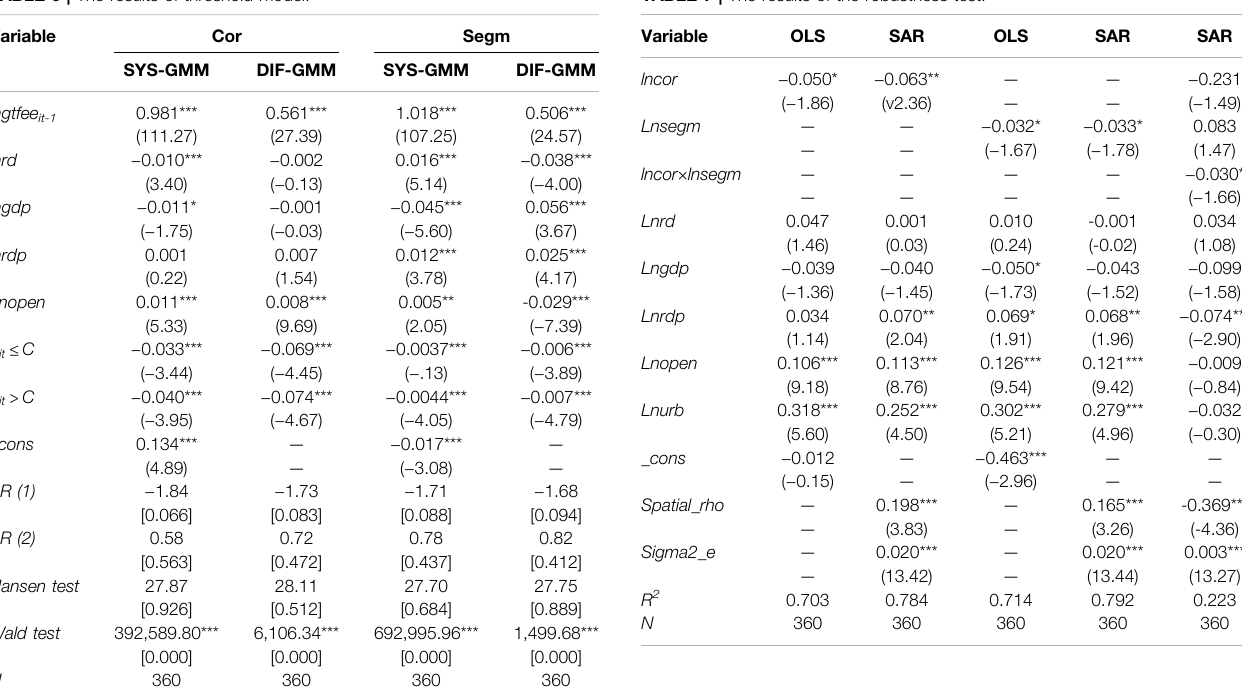
TABLE 6 | The results of threshold model. TABLE 7 | The results of the robustness